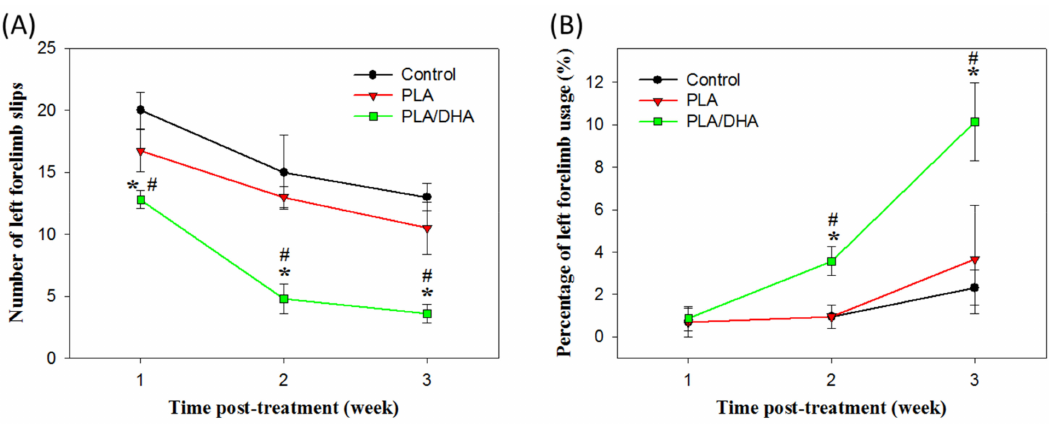
Figure 9. The evaluation of the neurological function recovery by the grid exploration test ( A ) and the cylinder test ( B ) using a spinal cord injury model in rats. The lesion was covered with a polylactic acid (PLA) or a polylactic acid / docosahexaenoic acid (PLA / DHA) core-shell nanofiber membrane for treatment. The control group received no treatment. * p < 0.05 compared with control, # p < 0.05 compared with